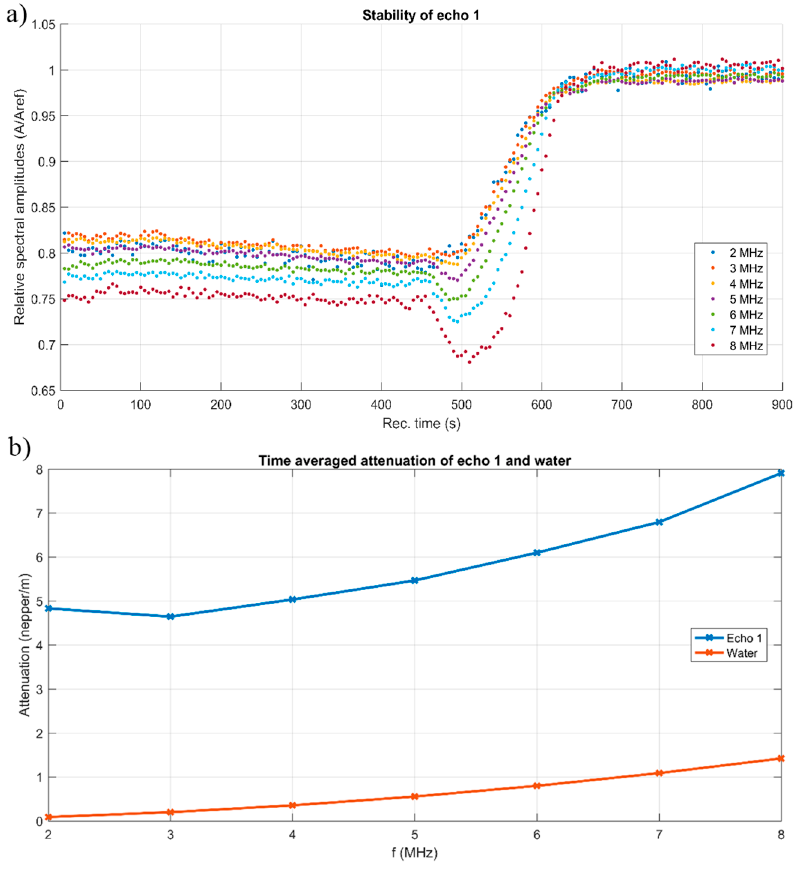
Figure 1. Spectral amplitudes relative variation vs. time, for the first echo ( a ) and attenuation vs. frequency for the first transmitted echo ( b ).